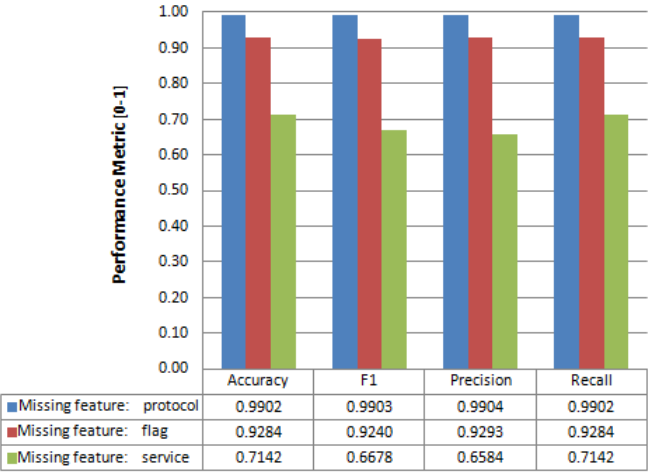
Figure 8. Performance metrics (aggregated) for predicting missing features of NSL-KDD test dataset.